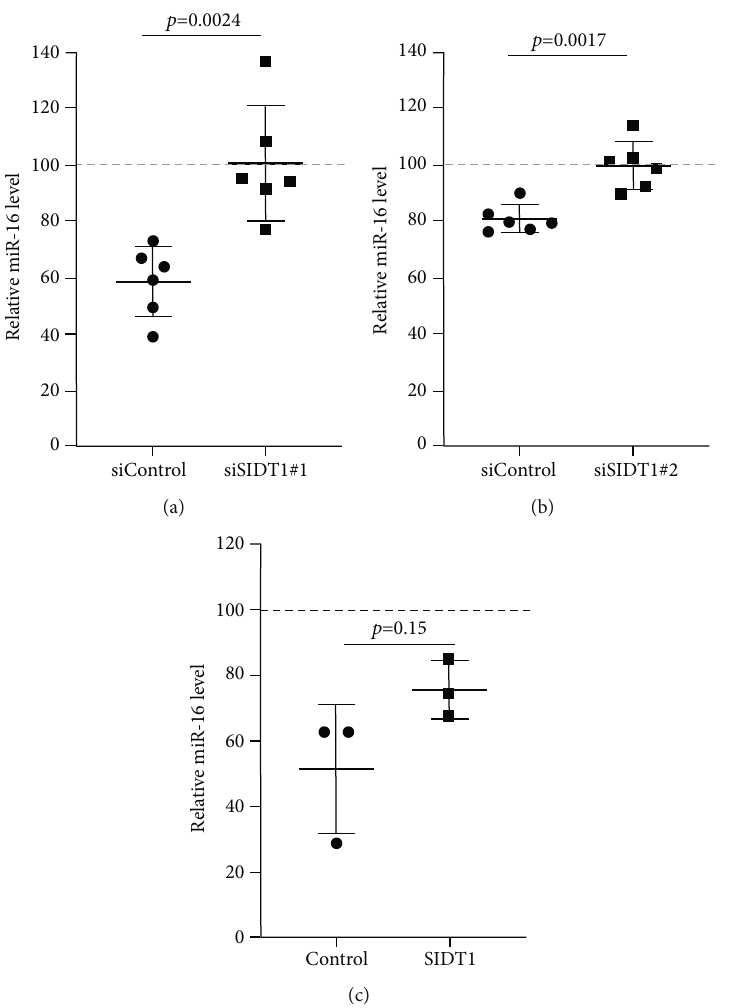
Figure 5: Perturbing the normal level of SIDT1 dampens the antimir-16 e ff ect. (a) and (b) MEFs were transfected with siControl, siSIDT1#1, or siSIDT1#2 for 72 hours. Then, cells were rinsed with PBS and cultured with (+) or without ( – ) antimir-16 (20 nM) for 6 hours. miR-16 levels were analyzed by qPCR and normalized against β -actin mRNA levels. The miR-16 levels are expressed as percentages relative to those in MEFs untreated with antimir-16. Error bars indicate s.d. ( n = 6 ). (c) MEFs were transfected with the empty plasmid or pCI-neo-SIDT1 for 48 hours. Cells were rinsed with PBS, and cultured with (+) or without ( – ) antimir-16 (20 nM) for 6 hours. The miR-16 levels were analyzed as above. Error bars indicate s.d. ( n = 3